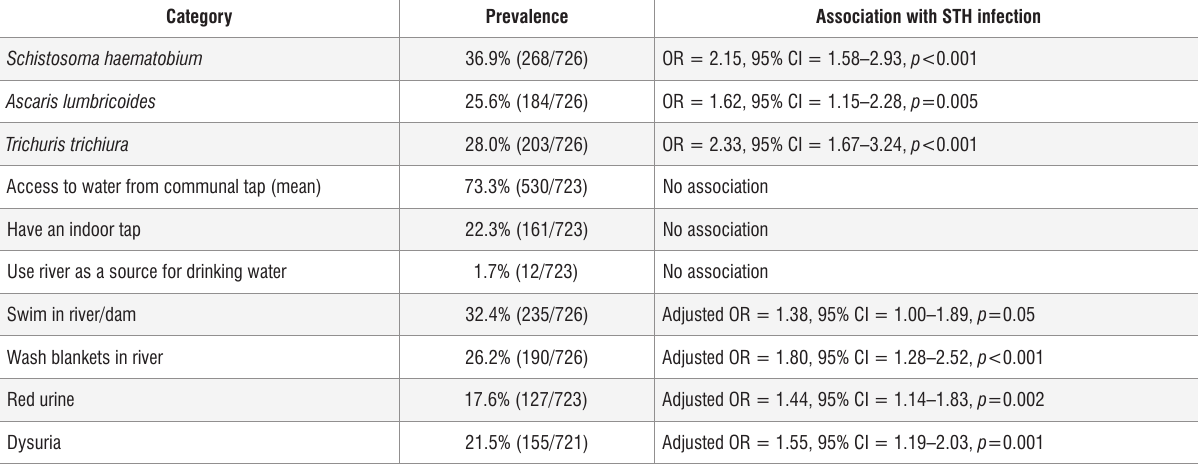
Descriptive characteristics of the study population, prevalence of Schistosoma haematobium, Ascaris lumbricoides, Trichuris trichiura, and association with soil-transmitted helminth (STH) infection Category